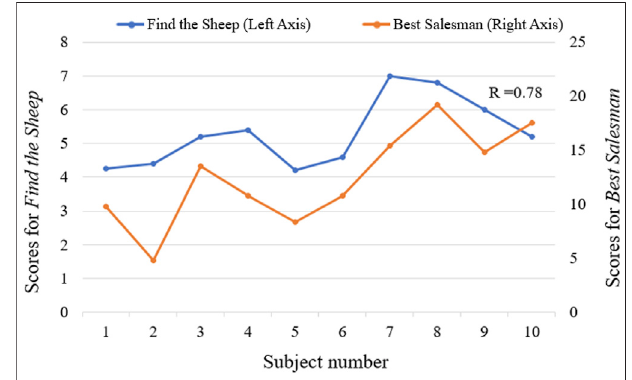
FIGURE 11 | The correlation between average scores of serious games “ Find the Sheep ” and “ Best Salesman ” ( r = 0.78, p <